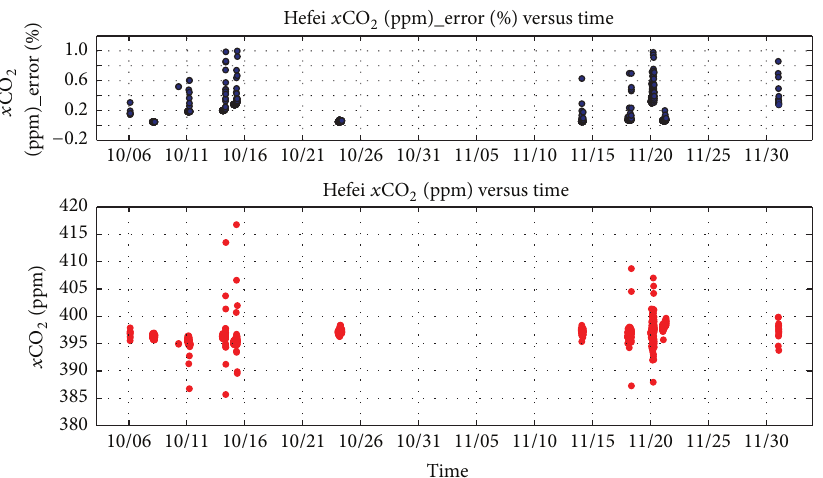
Figure 8: DMF time series ranging from October 6, 2014, to December 1, 2014, which are calculated according to VCD CO 2